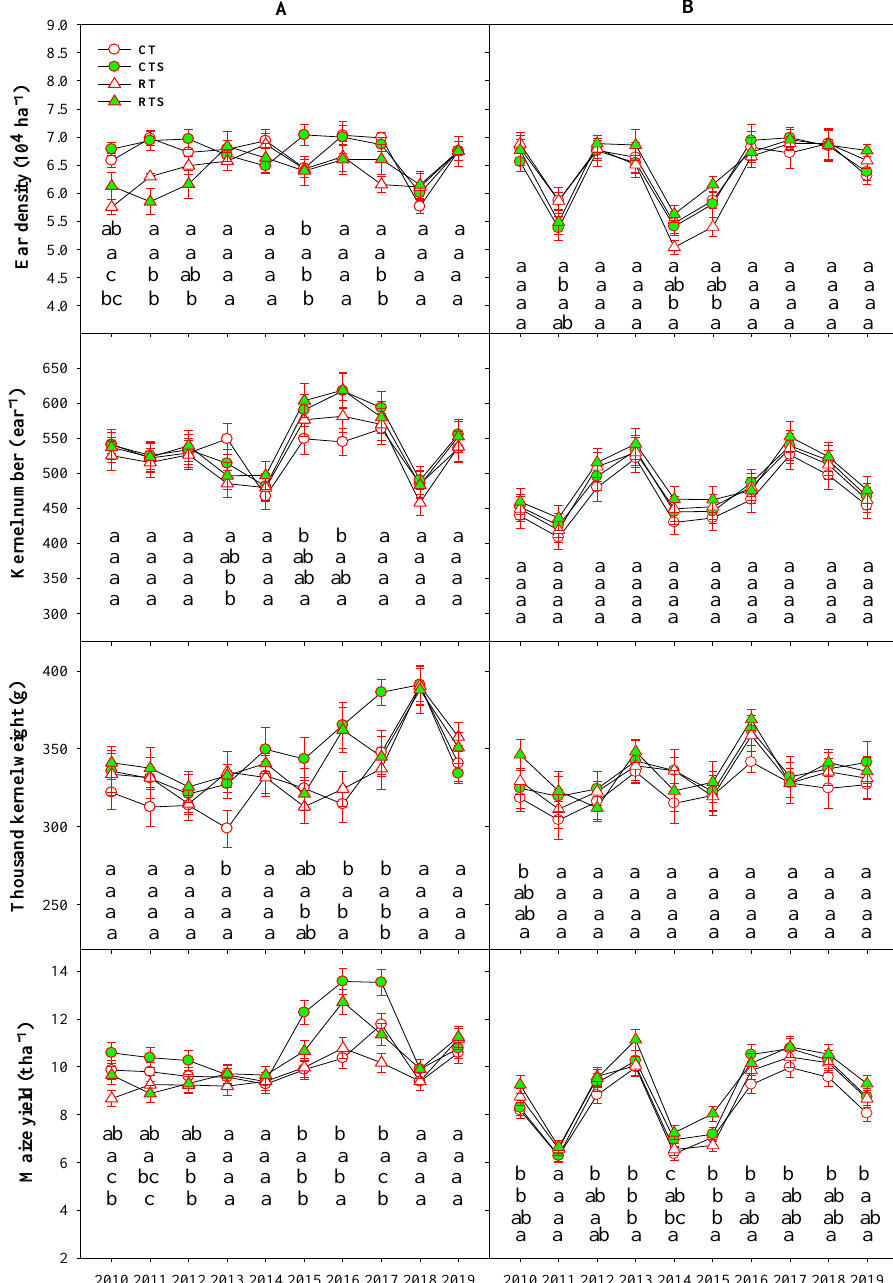
Figure 5. Maize yield and yield components over time under tillage and straw returning practices at the Tai’an ( A ) and Longkou ( B ) experimental sites. CT: conventional tillage without straw returning; CTS: conventional tillage with straw returning; RT: rotary tillage without straw returning; RTS: rotary tillage with straw returning. T-like lines: standard deviation. Different letters in each column indicate significant differences between different treatments ( p < 0.05 ; Duncan’s test).